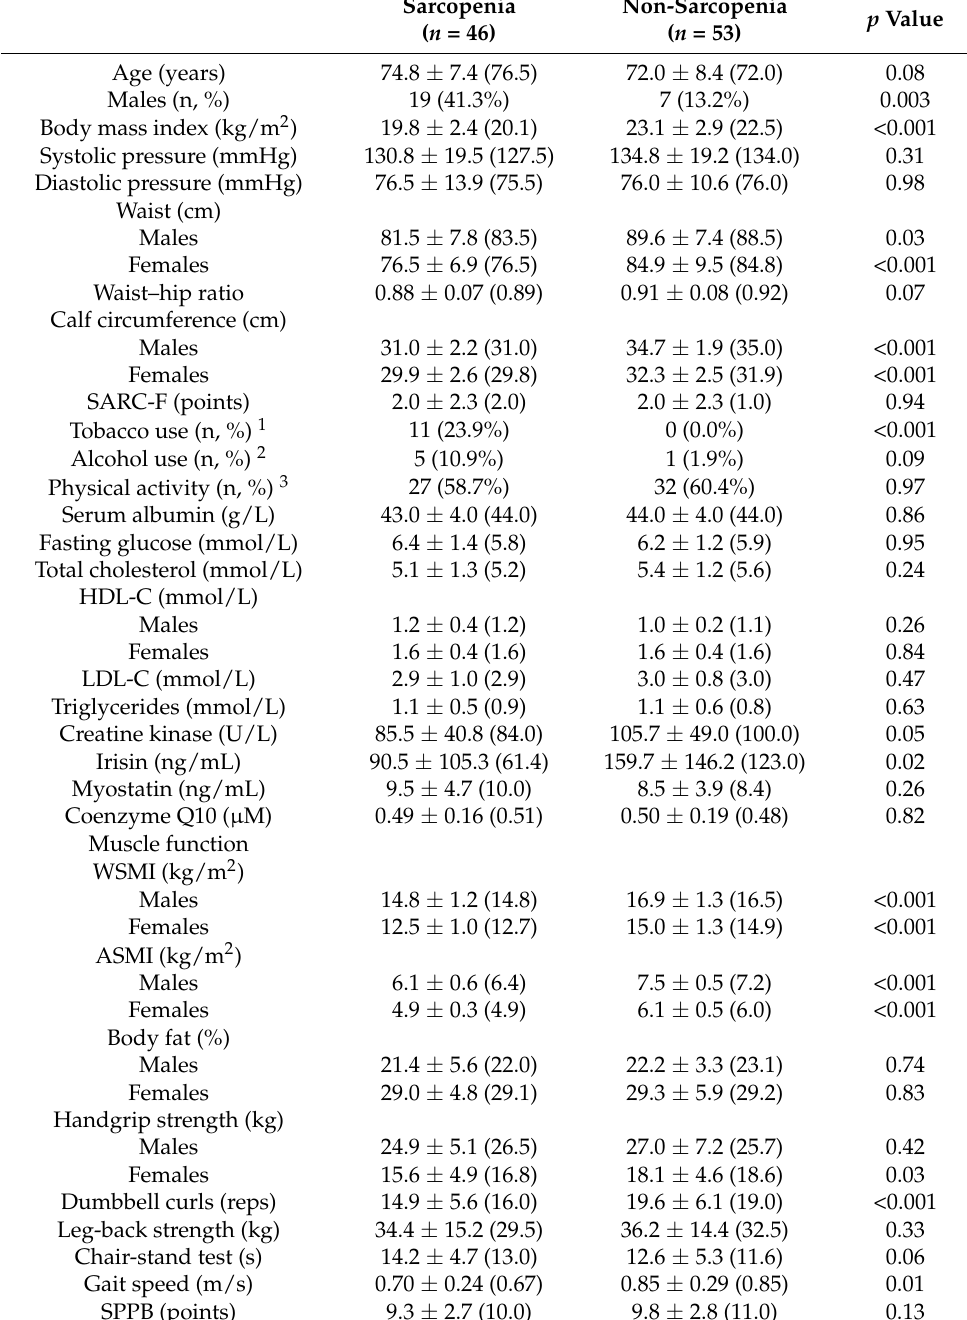
Table 1. Characteristic data of